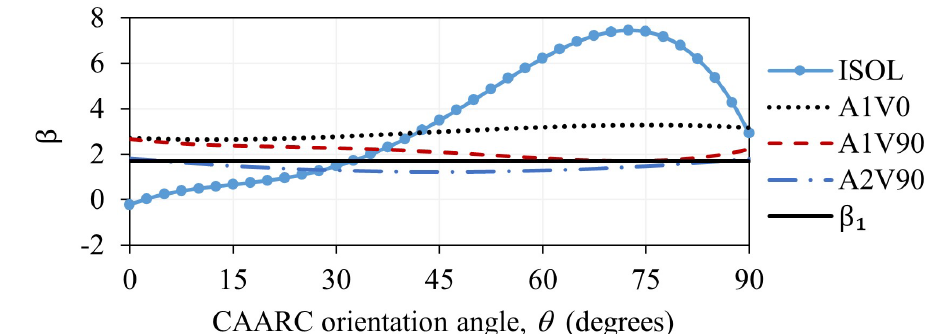
Figure 11. Reliability index β for displacement, x-direction – limit criterion of H/1700.